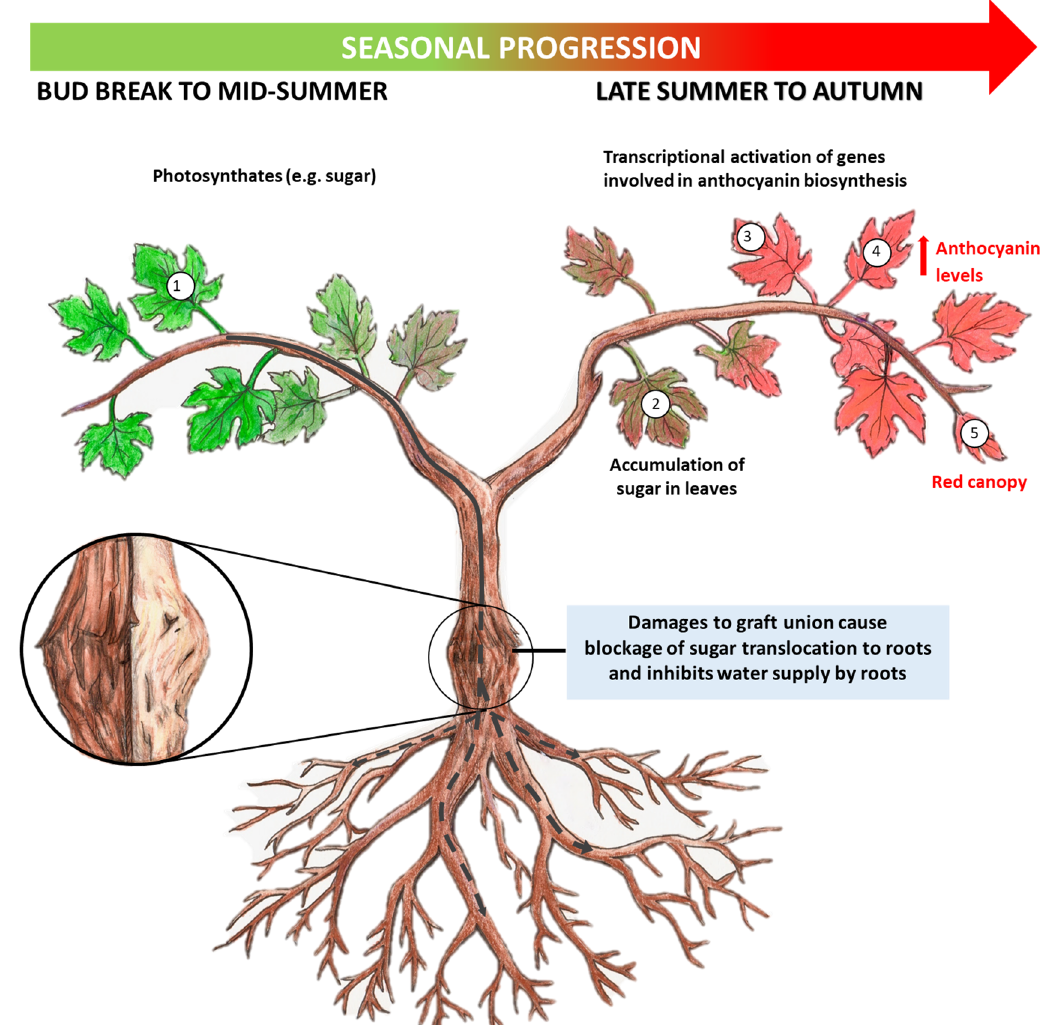
Figure 4. Proposed model of the pathogenesis of Syrah decline. Syrah decline is a physiological response to alterations at the graft union induced by viruses, which can be from the scion, the rootstock or both. Though it is a possibility that infection with a single virus may cause Syrah decline, it is more likely that mixed infections with multiple viruses and viral strains are involved. Viral infections induce cytopathic effects to cambium cells at the graft union, leading to disjunction and incompatibility between the scion and the rootstock. With time, this leads to the development of swelling, cracking, grooving and necrosis at the graft union. Consequently, sugar export from leaves will be impeded, leading to red discoloration of leaves on a portion or the entirety of the vine. In essence, Syrah decline is simply an extreme manifestation of rugose wood syndrome, which is unique to Syrah cultivars. For a detailed account of the model, please refer to Section